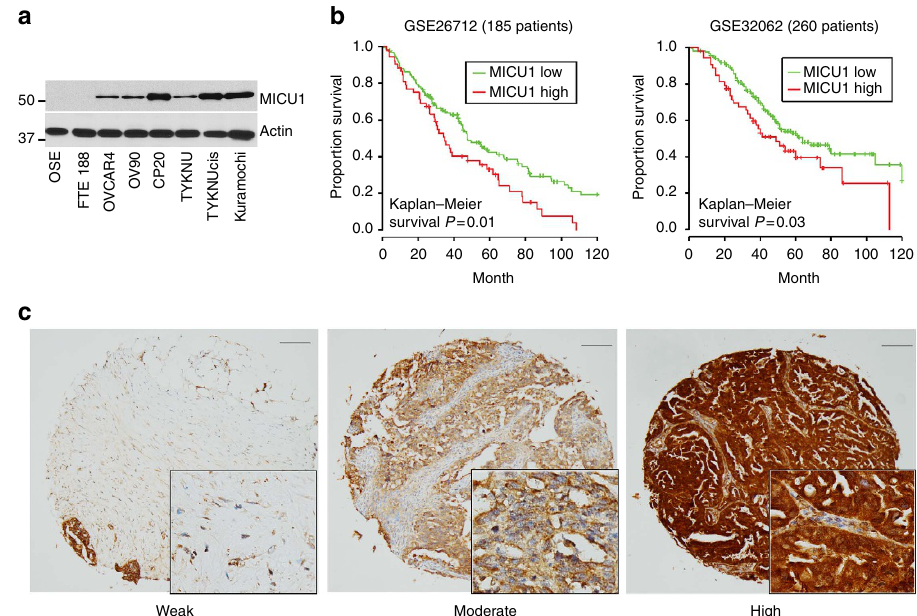
Figure 1 | Expression and pathological significance of MICU1 in OvCa. ( a ) Expression of MICU1 in various ovarian cell lines as determined by immunoblotting. Actin is used as the loading control. ( b ) Kaplan-Meier overall survival curves in MICU1 low and high expression OvCa cases from GEO databases. The proportion survival is plotted versus time since diagnosis in months. Kaplan-Meier curves with a log-rank test where P value o 0.05 considered significant. ( c ) Immunohistochemical (IHC) staining of a tissue microarray of drug-resistant epithelial OvCa samples for MICU1 (1:150). Representative images taken at (cid:2) 4 magnification are shown of (i) weak, (ii) moderate and (iii) high staining. Inset shows magnified areas of individual IHC stains taken at (cid:2) 20 magnification. Scale: 100 m